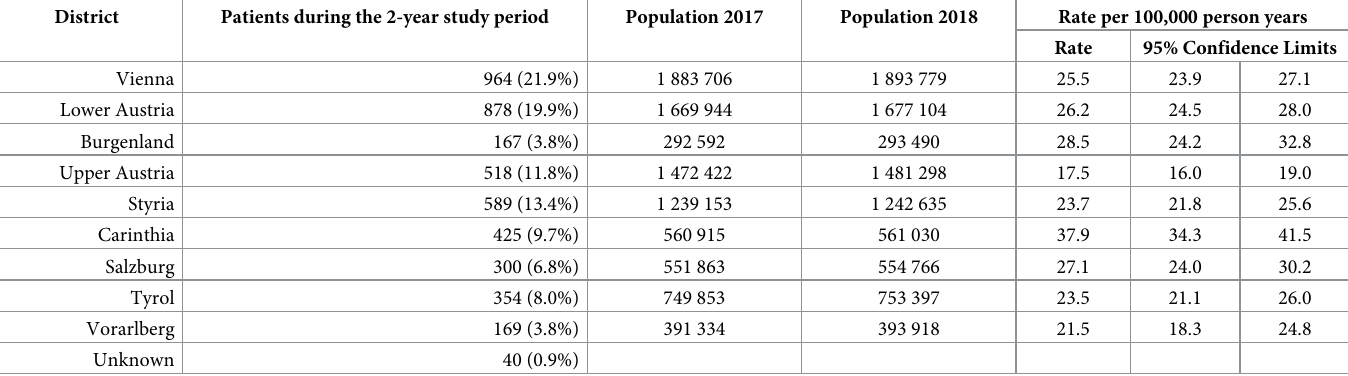
Table 2. Geographical locations of all patients who requested a health care allowance in 2017 and 2018 in Austria because of a diagnosis-related minimum classifi- cation of visual impairment, blindness and deaf-blindness. District Patients during the 2-year study